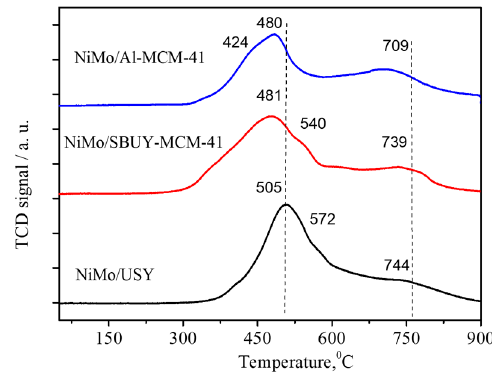
Figure 2. H 2 -TPR profiles for NiMo catalysts supported on USY and SBUY-MCM-41.